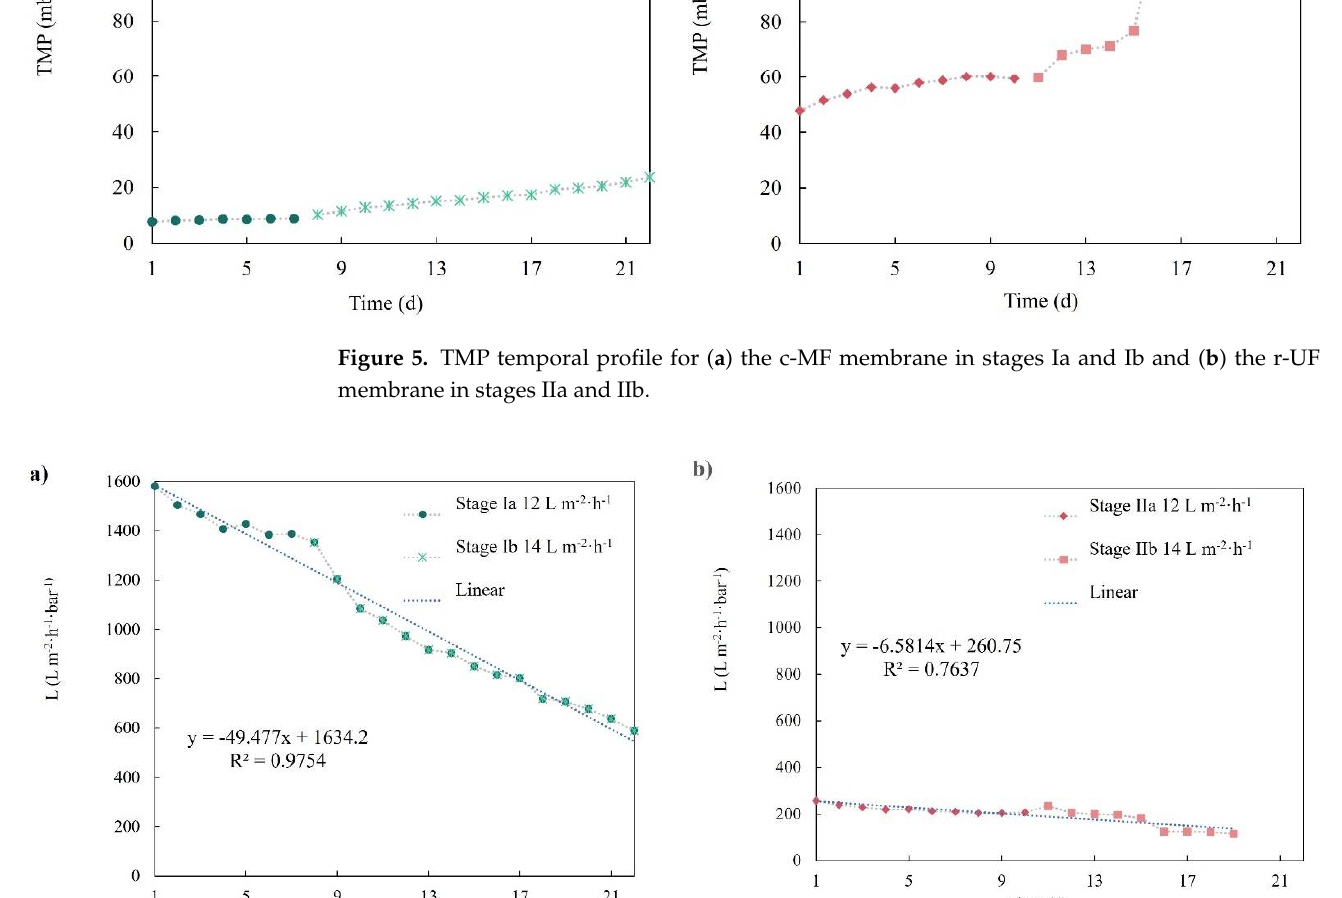
Figure 5. TMP temporal profile for ( a ) the c-MF membrane in stages Ia and Ib and ( b ) the r-UF membrane in stages IIa and IIb.